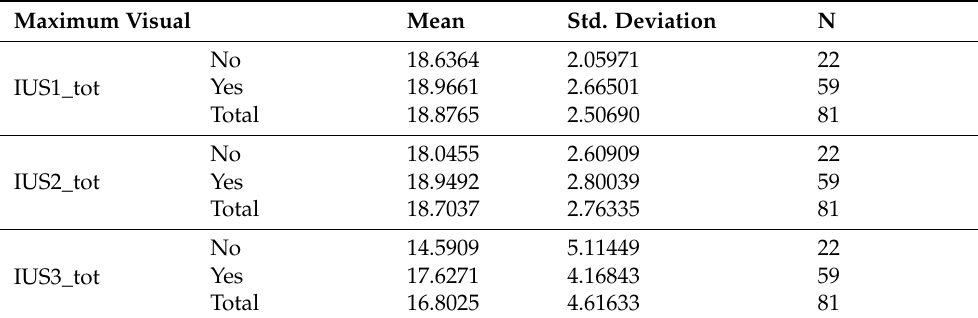
Table 9. Means’ analysis—intention to use (IU). Maximum Visual